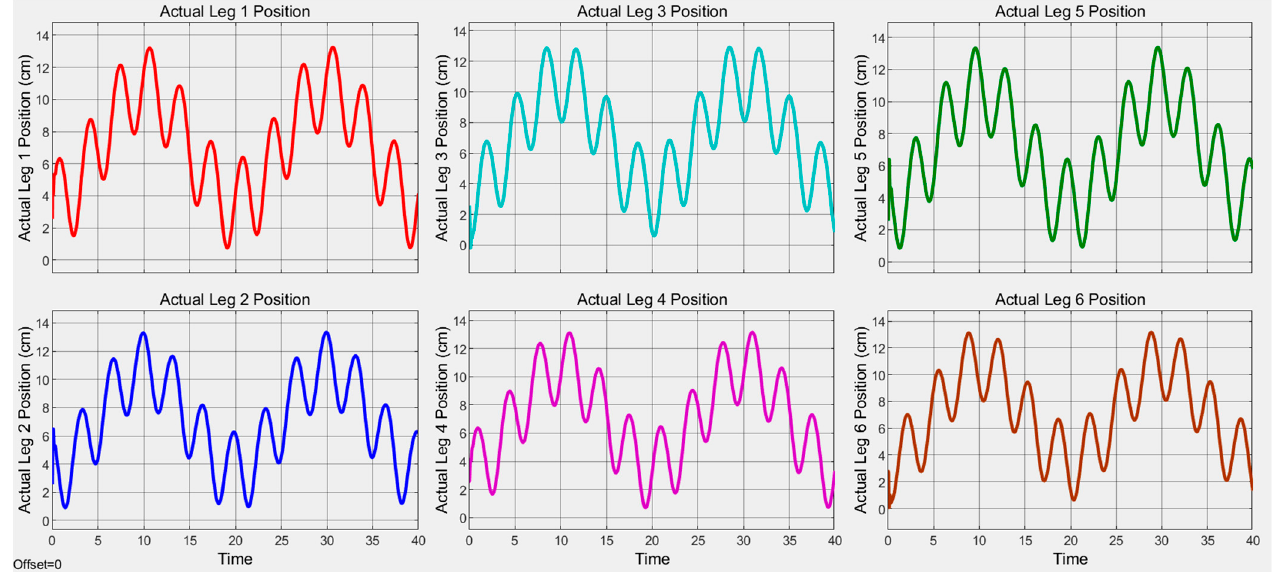
Figure 16. Actual leg position simulation results for reference trajectory.